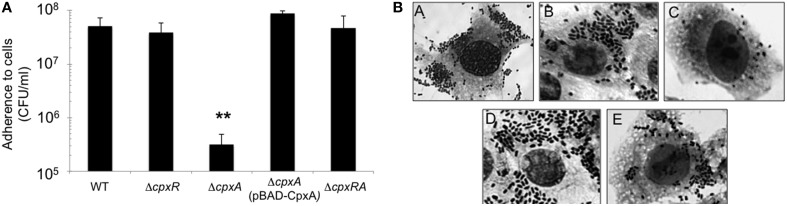
CpxA kinase sensor is required for EHEC adherence. (A) Quantification of bacterial adherence to human cells. The indicated strains were incubated with HeLa cells for 3 h and the adherent bacteria expressed as CFUs after plating serial dilutions. The data are representative of a least three experiments performed in triplicate. (B) Giemsa staining of HeLa cell monolayers infected for 3 h with EHEC EDL933 (A), ΔcpxR (B), ΔcpxA (C), ΔcpxA (pBAD-CpxA) (D), ΔcpxRA (E). Adherence of the cpxA mutant is statistically significant with respect to that shown by the WT strain **p < 0.01.